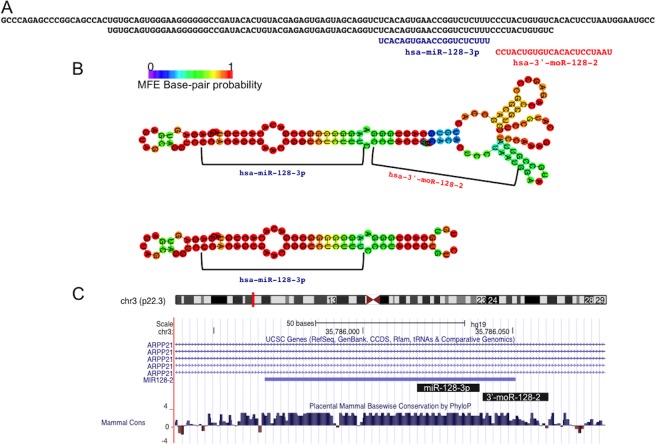
The 3’-moR-128-2 is produced by the precursor sequence of miR-128-3p.A) The moRNA is derived from a region of the primary miRNA sequence exceeding the canonical hairpin precursor sequence, and it is not exaclty adjactent to the annotated miRNA. B) Minimum free energy (MFE) folding structure, predicted by RNAfold, for the canonical hairpin sequence and for the longer one, from which the moRNA is probably derived. C) Both the considered small RNAs are conserved in evolution through vertebrates.